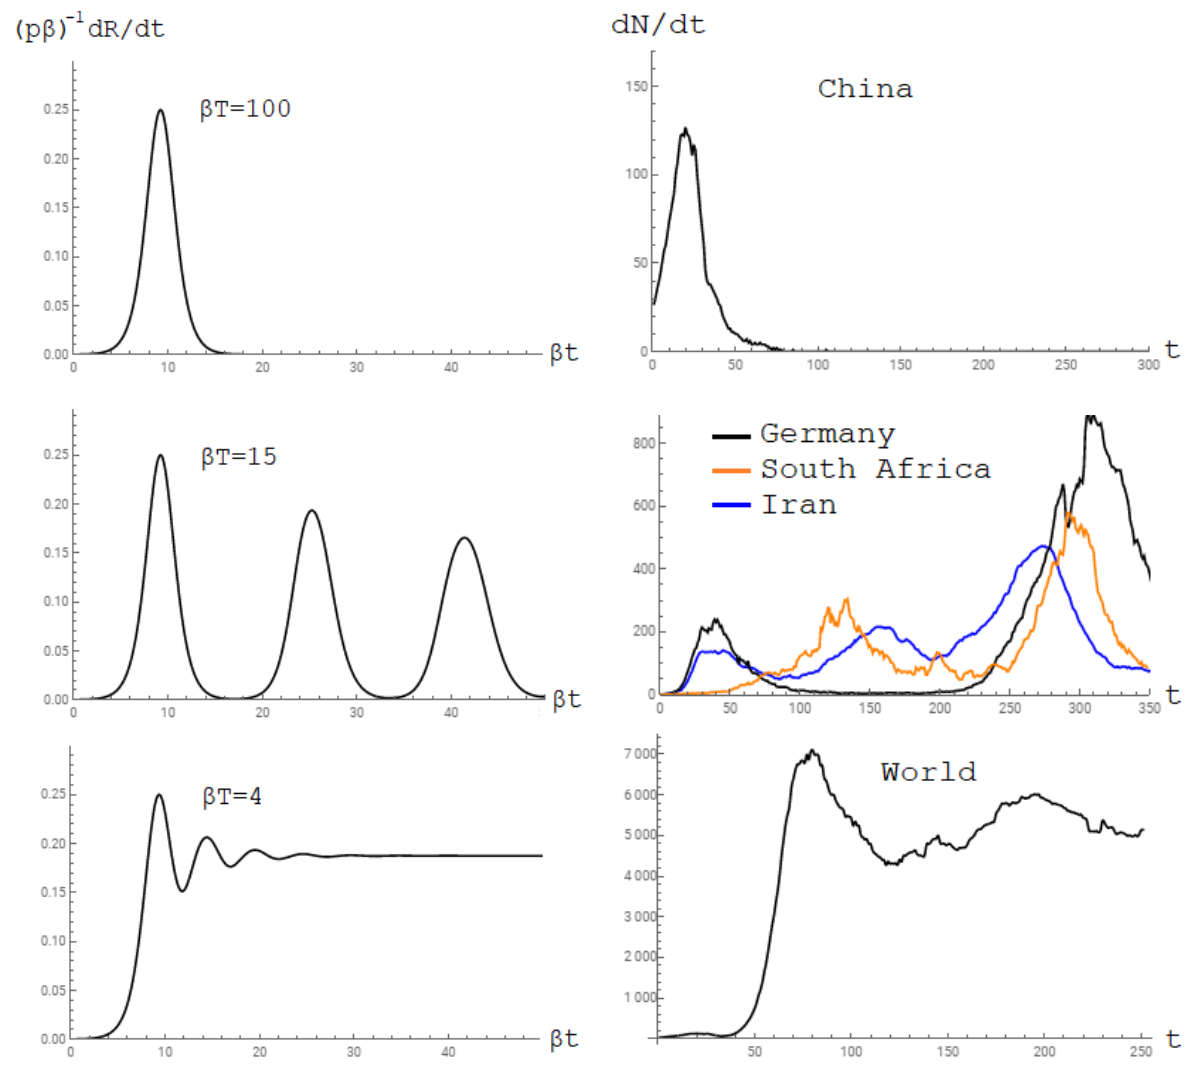
Figure 7. Waves of daily incidence 𝒅𝑹/𝒅𝒕 = 𝒑 𝒅𝑰/𝒅𝒕 depending on the value of 𝜷𝑻 . The wave solutions are qualitatively compared with death rate curves from China, from three selected countries (Germany, South Africa, Iran), and from the total world [4].